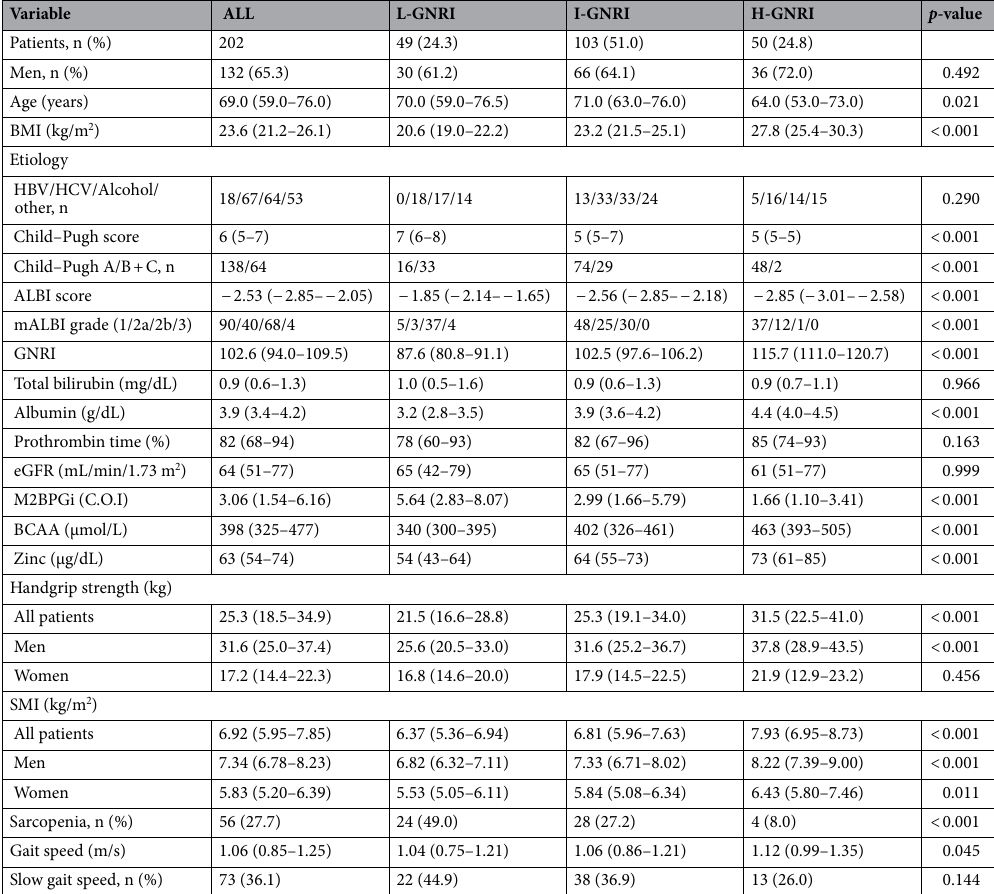
Table 1. Comparison of clinical characteristics among the three groups based on the GNRI values. Values are shown as median (interquartile range) or number (percentage). Statistical analysis was performed using the chi-squared test or the Kruskal–Wallis test, as appropriate. ALBI albumin-bilirubin, BCAA branched-chain amino acid, BMI body mass index, eGFR estimated glomerular filtration rate, GNRI Geriatric Nutritional